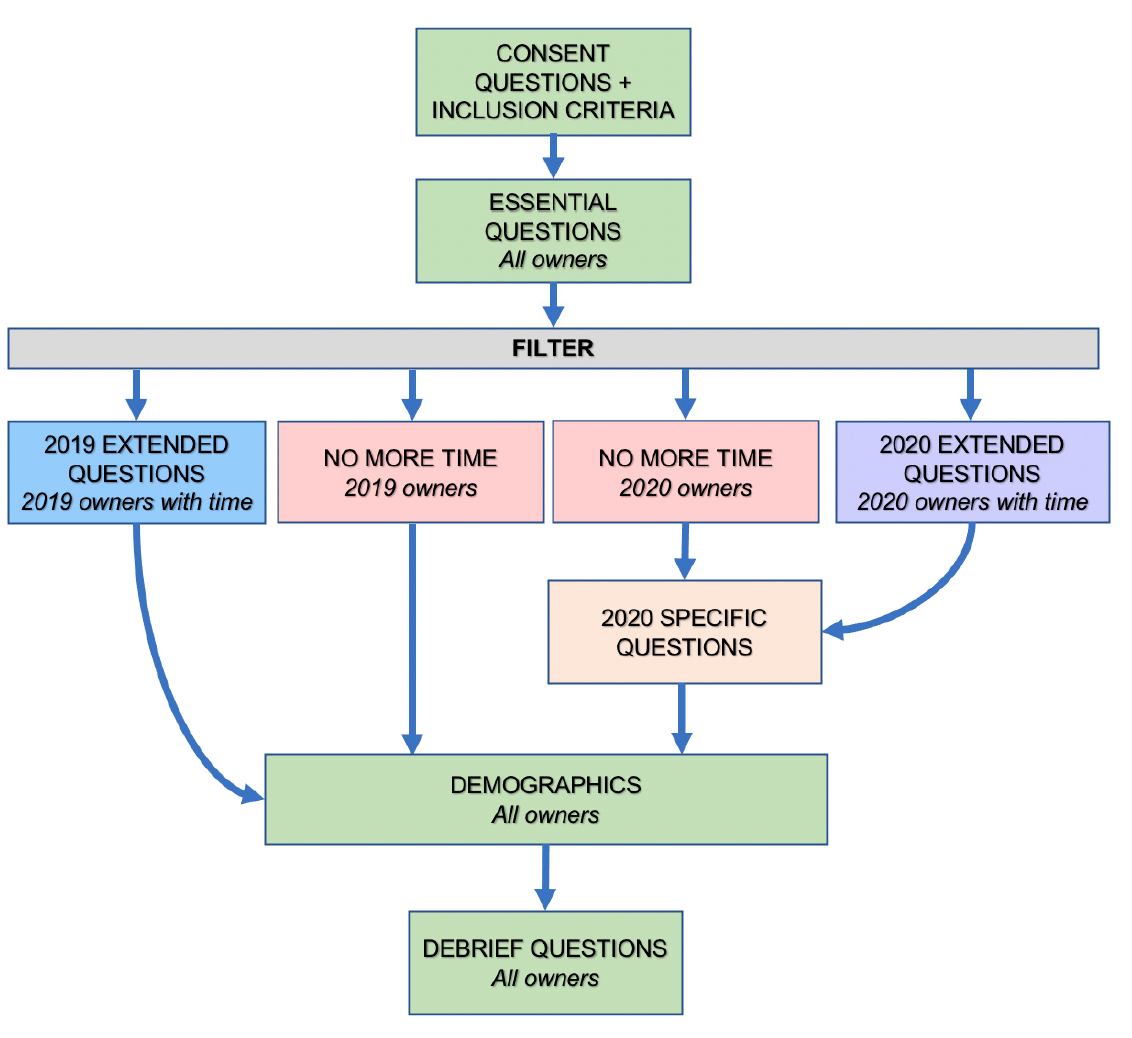
Figure 2. Schematic representation of the survey logic employed to allow different survey routes for owners depending upon year of acquisition and time constraints.